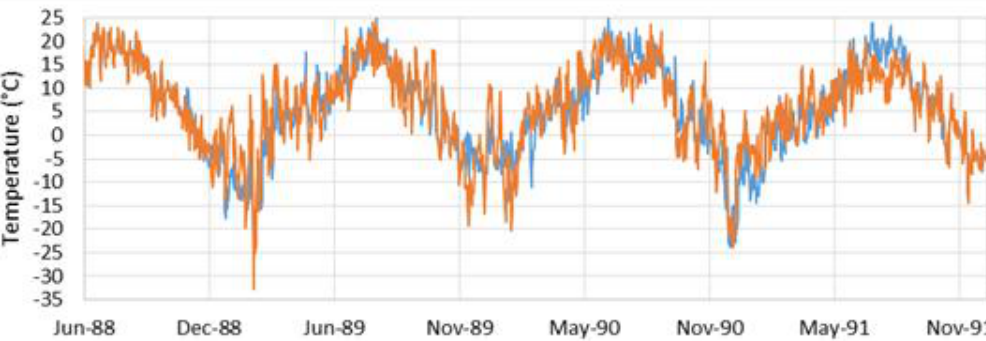
Figure 9. Results from the first realization of data imputation over a 1095-day (3-year) gap. This realization closely matches the seasonal variations and does a good job on the shorter fluctuations. It does not accurately match the extremely low temperature in the winter of 1988 but does a very good job in the other years.